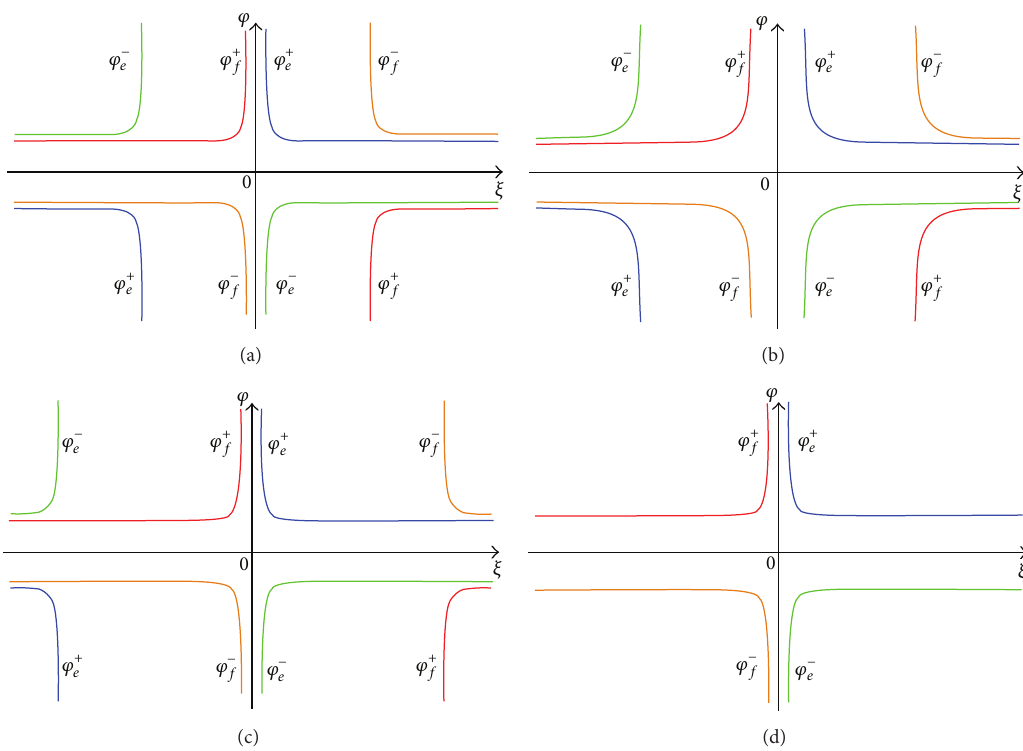
: 𝑝 = 3𝑞 2 /16𝑟 = 3, and 𝜇 = −4 and (a) 2